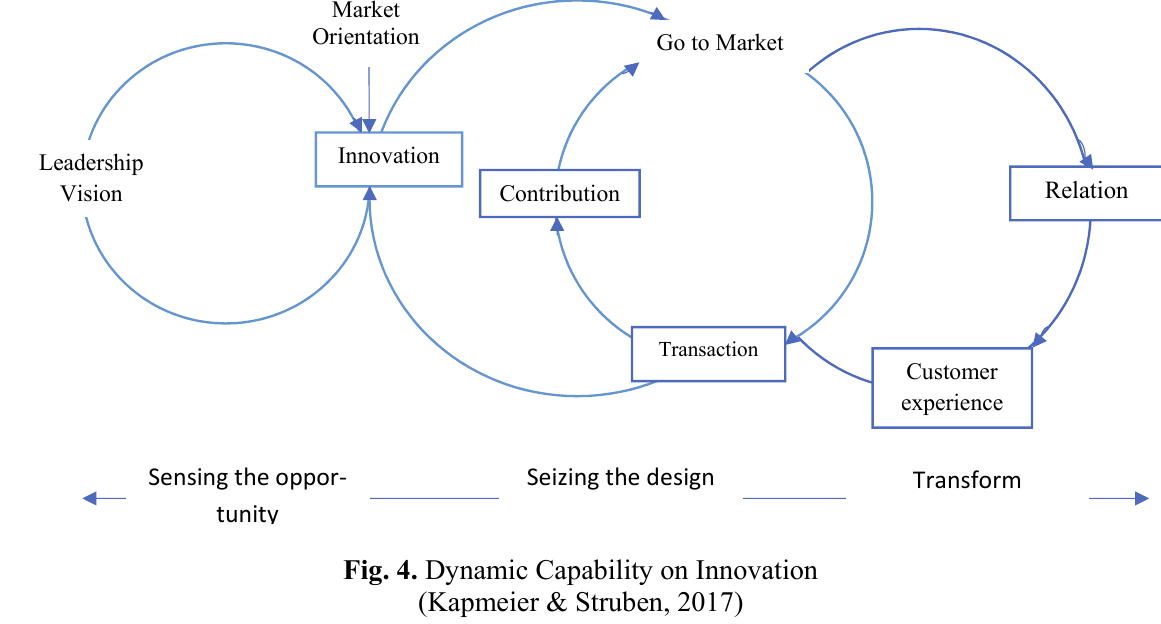
Fig. 4. Dynamic Capability on Innovation (Kapmeier & Struben,